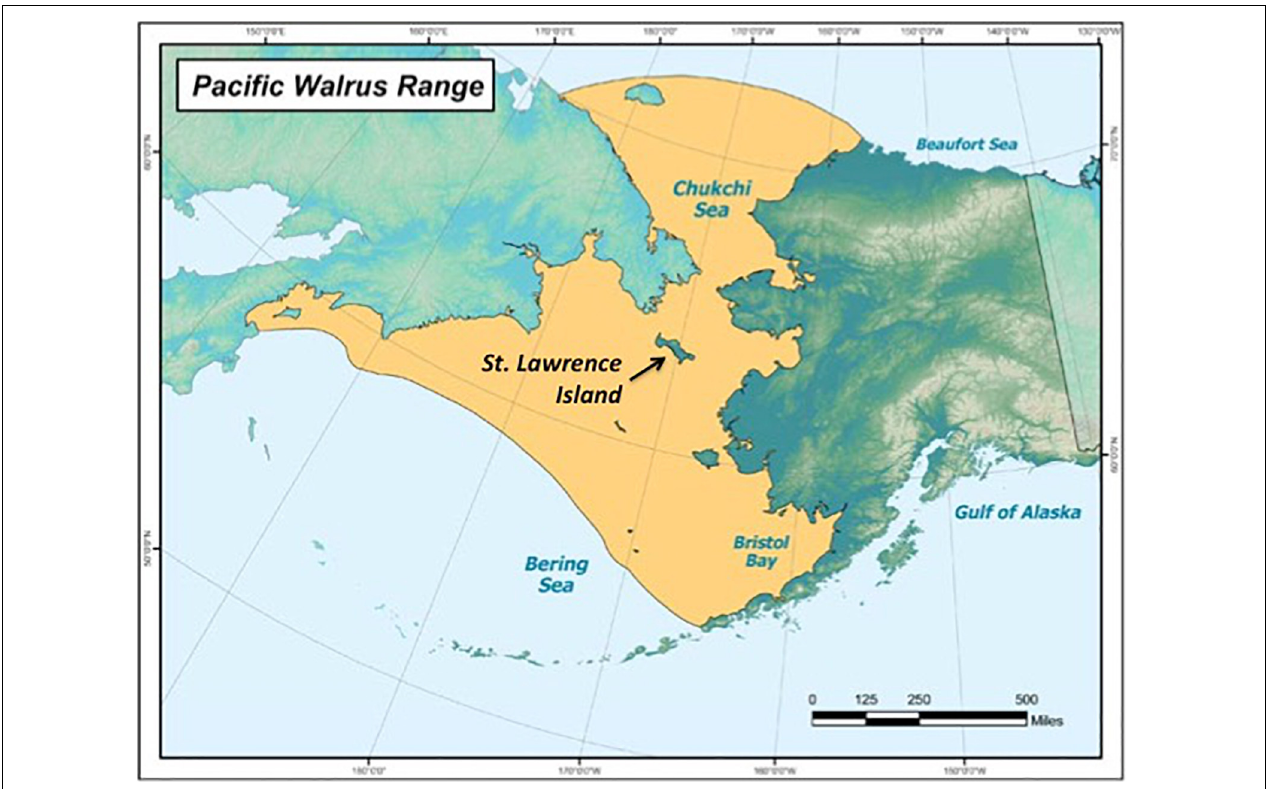
FIGURE 1 | The Pacific walrus ( Odobenus rosmarus divergens ) range, including St. Lawrence Island, Alaska, which lies in the migration path (source: Alaska Department of Fish and Game (ADFG),